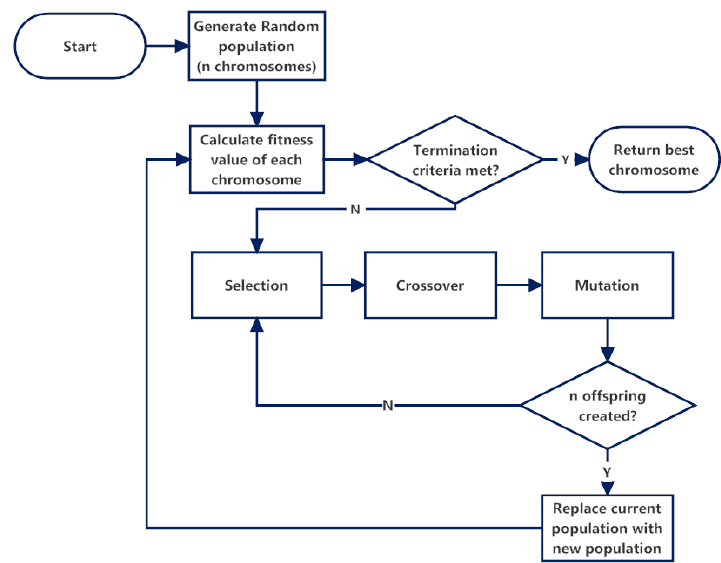
Figure 1. Flowchart of Simple genetic algorithm (Simple